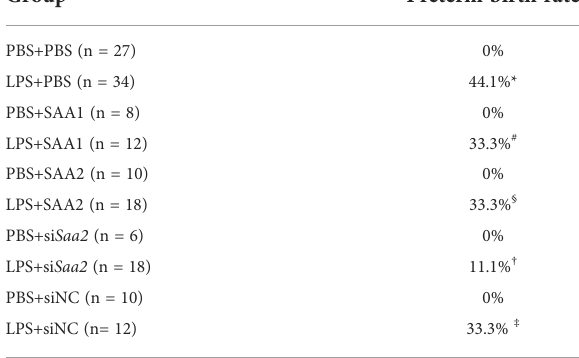
TABLE 1 Preterm birth